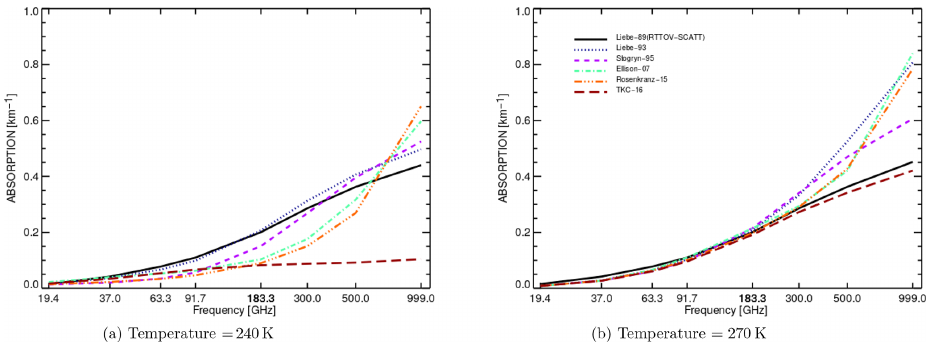
Figure 2. Absorption as a function of different microwave frequencies for liquid water clouds with 0.1gm − 3 water content at temperatures of (a) T = 240K and (b) T = 270K. For the construction of these figures, absorption values have been computed at 19.4, 37, 63.3, 91.7, 183, 300, 500 and 999GHz. Values of absorption between these frequencies are linearly